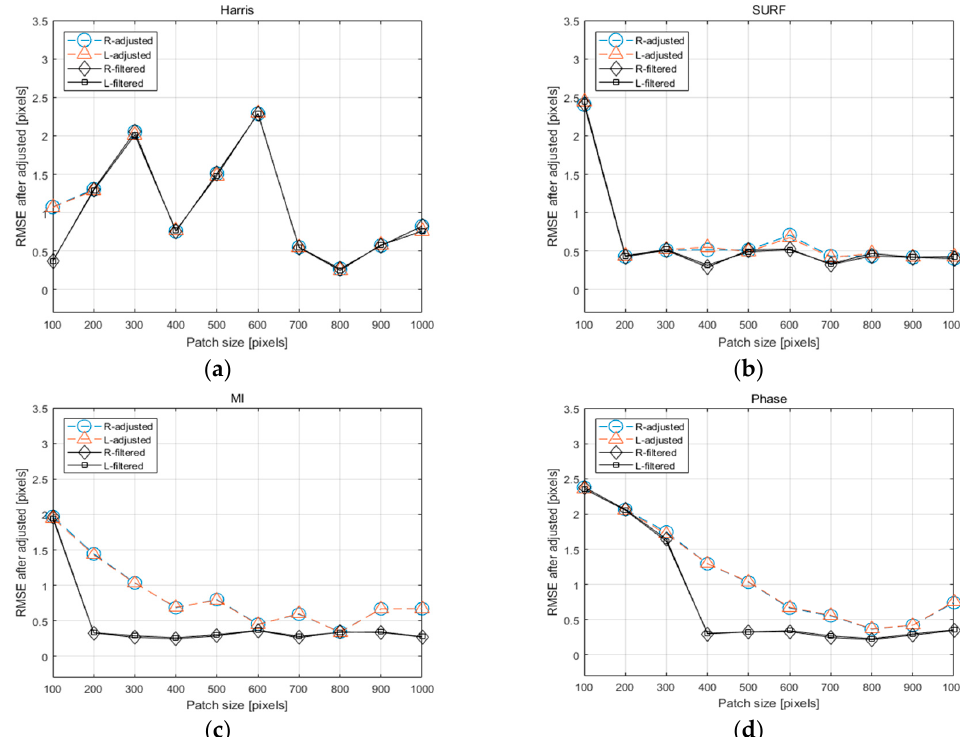
Figure 19. Reprojection errors (along-track Kompsat-3 coarse epipolar—after adjustment): ( a ) HARRIS–FREAK ( b ) SURF, ( c ) MI, and ( d ) PC.